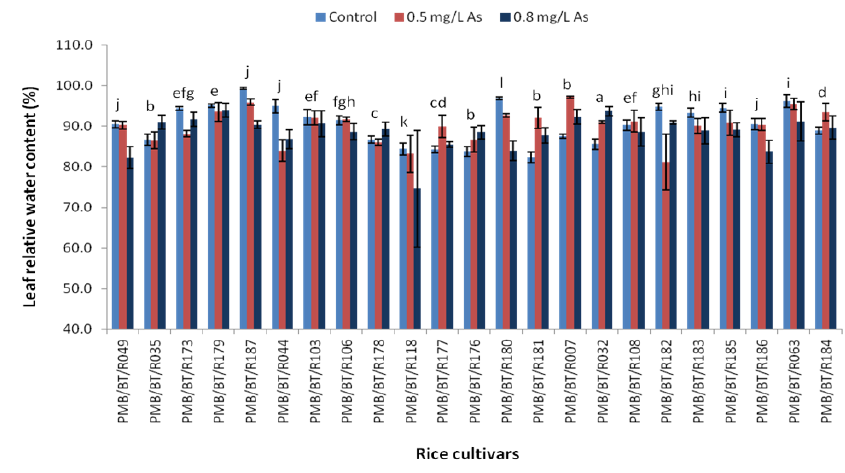
Figure 5 Leaf relative water content (%) under arsenic stress. Data are presented as the mean ± SE , n = 3. Columns topped by the same letter(s) indicate that the percentage changes in the parameter values of the presented cultivars under 0.8 mg/L arsenic stress do not differ significantly at the 5% level according to Duncan’s multiple-range